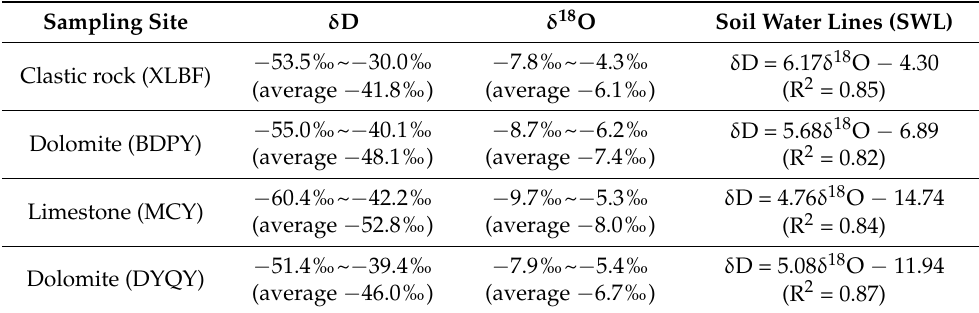
Figure 5. Local meteoric water line and distribution characteristics of δ 18 O and δ D in different water bodies at four sampling points in the study area. Table 2. Equations for soil water line in sampling